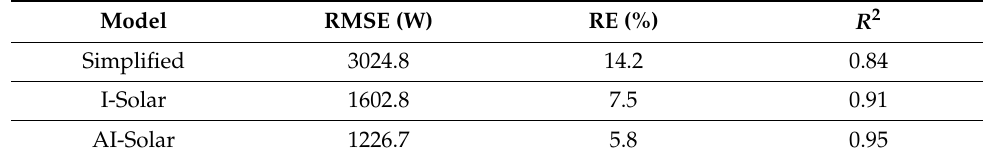
Table 6. Statistical analysis of adjustment of the evaluated models.